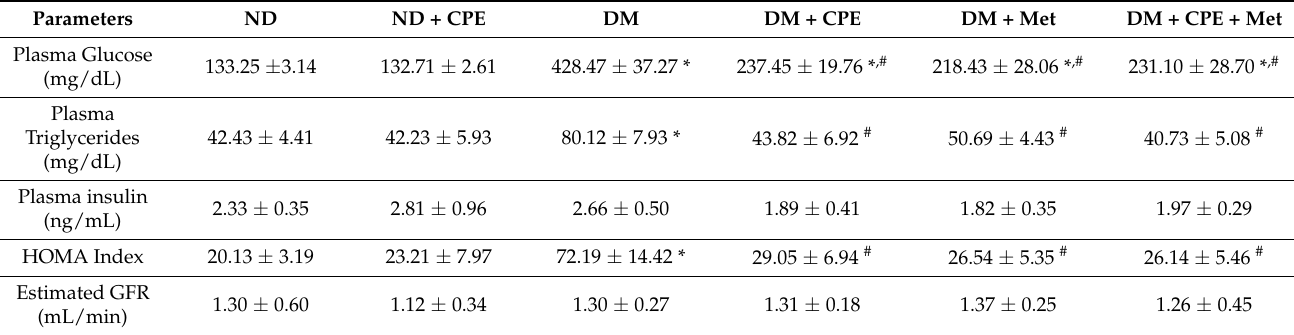
Table 2. Effect of CPE on selected biochemical parameters of carbohydrate and lipid metabolism as well as general kidney function in